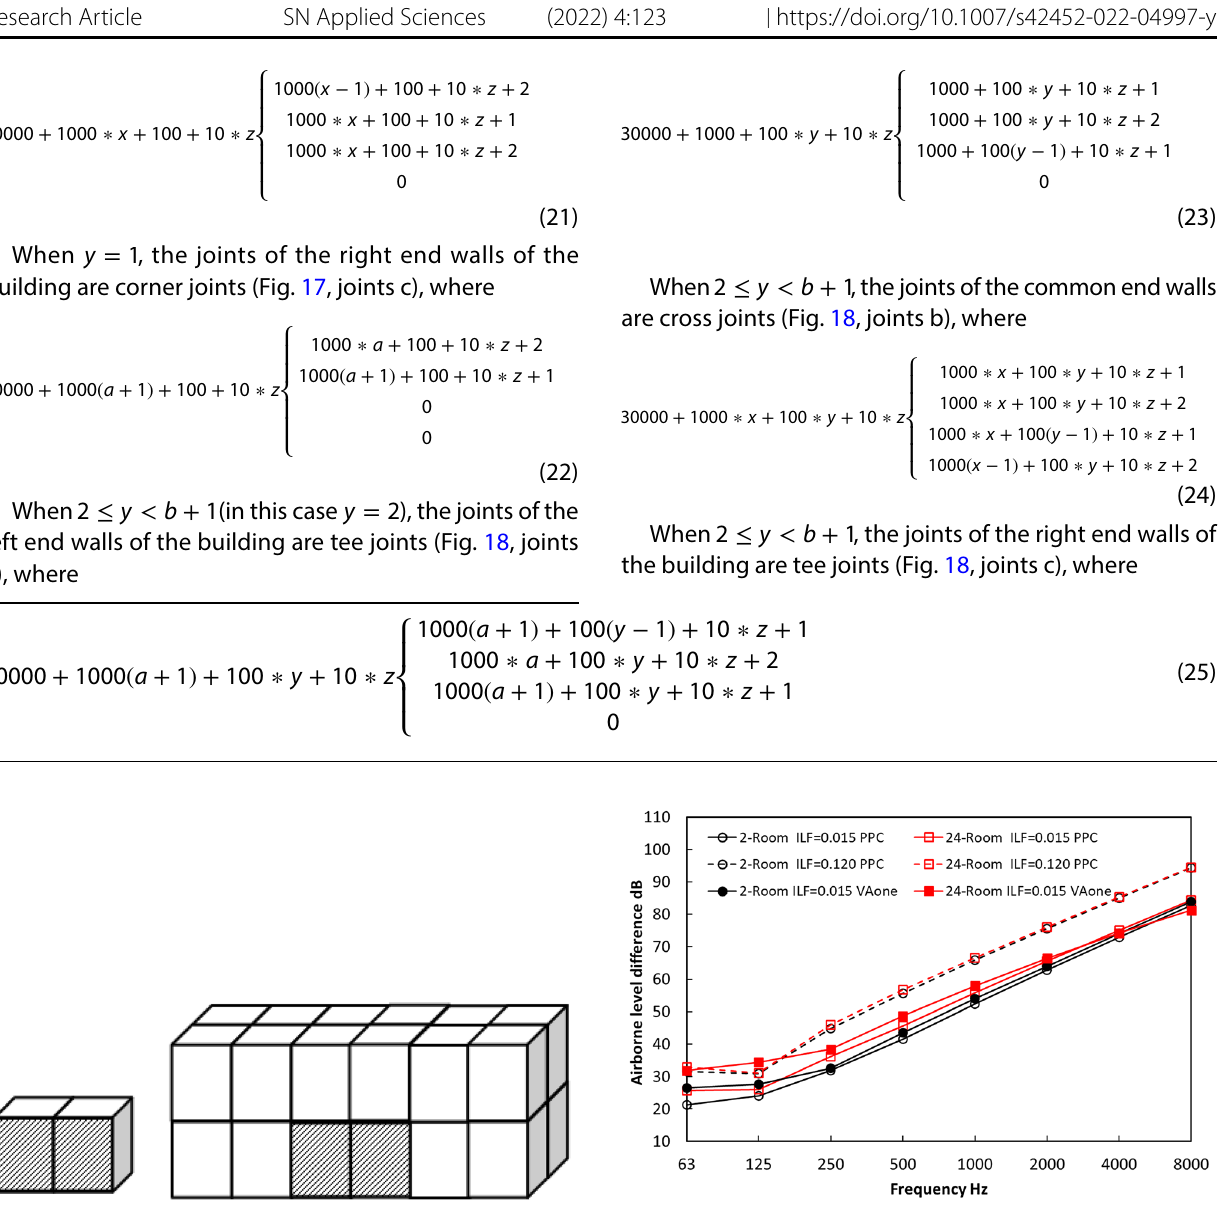
Fig. 20 Illustration of a simple 2-room system and a complicated 24-room system (the shadowed rooms are the source room and the receiving room)